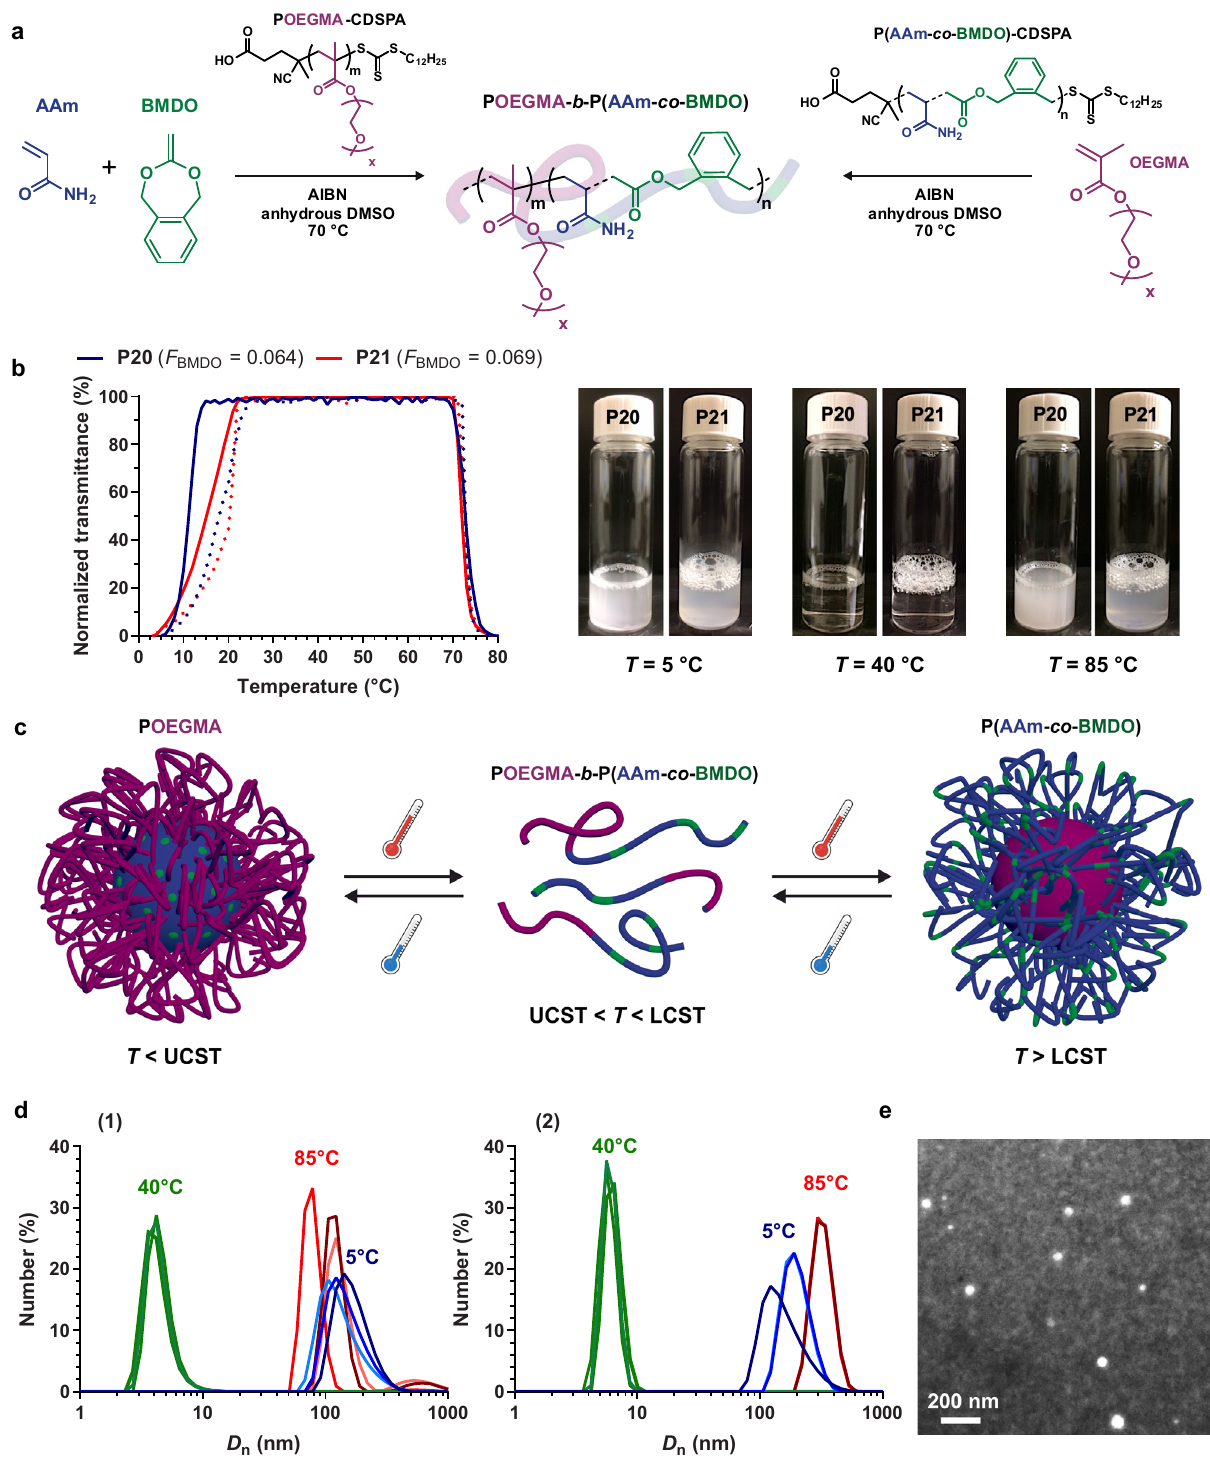
Fig. 8 Application to amphiphilic POEGMA- b -P(AAm- co -BMDO) diblock copolymers. a Synthesis of amphiphilic POEGMA- b -P(AAm- co -BMDO) ( P20 ) and P(AAm- co -BMDO)- b -POEGMA ( P21 ) diblock copolymers via RAFT polymerization at 70 °C in anhydrous DMSO using POEGMA or P(AAm- co - BMDO) as macro-CTA, respectively; b variation of the solution transmittance vs. temperature and associated pictures of the doubly thermoresponsive P(AAm- co -BMDO)- b -POEGMA diblock copolymers P20 – P21 solution in water at 10 mg mL − 1 (1 °C min − 1 , solid and dotted lines for cooling and heating, respectively); c schematic representation of the doubly thermoresponsive P(AAm- co -BMDO)- b -POEGMA diblock copolymer nanoparticles morphology upon temperature switch; d evolution of the number-average diameter ( D n ) of the doubly thermoresponsive P(AAm- co -BMDO)- b -POEGMA diblock copolymer nanoparticles P20 (1) and P21 (2) at 1.67 mg mL − 1 at T = 40 °C, 5 °C, and 85 °C. e Representative TEM image with negative staining of nanoparticles P20 (see Supplementary Figs. 39 and 40 for other TEM images and particle size distribution, respectively). This experiment was repeated three times with similar